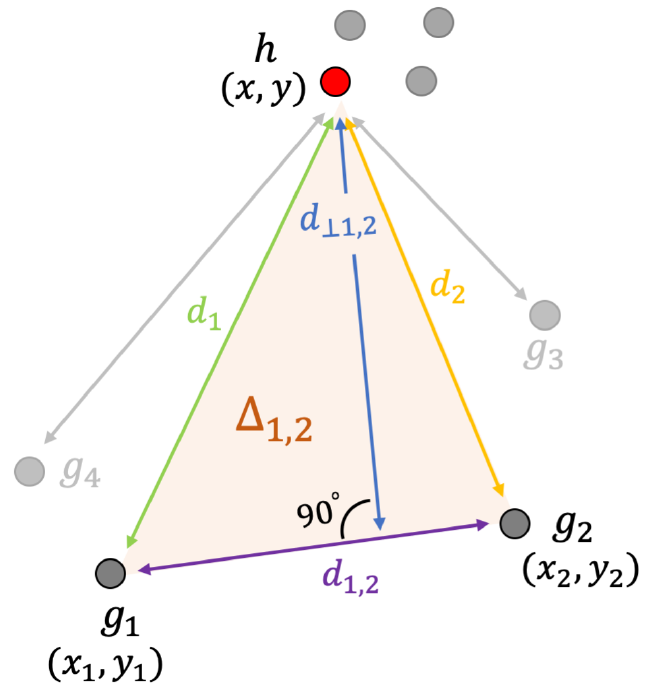
Figure 3. Example system configuration with a 4-antenna user G and a 4-antenna user H . The distances between each antenna pair are extracted from time-of-flight (ToF) estimates produced by a two-way ranging (TWR)